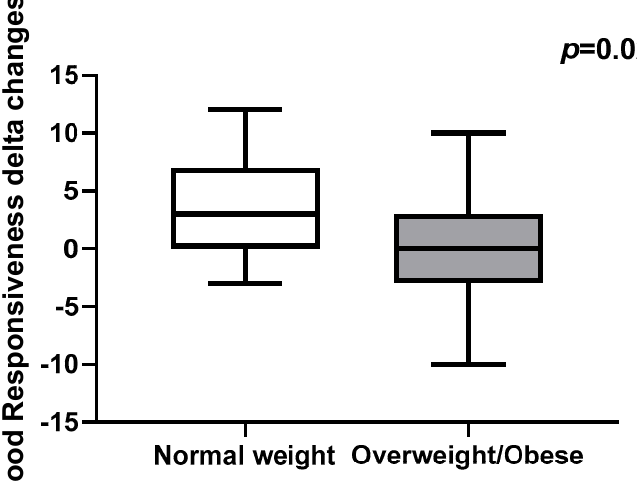
Figure 1. Delta changes in Food Responsiveness total scores in normal weight children and children with overweight and obesity. Data are expressed as median and interquartile range.